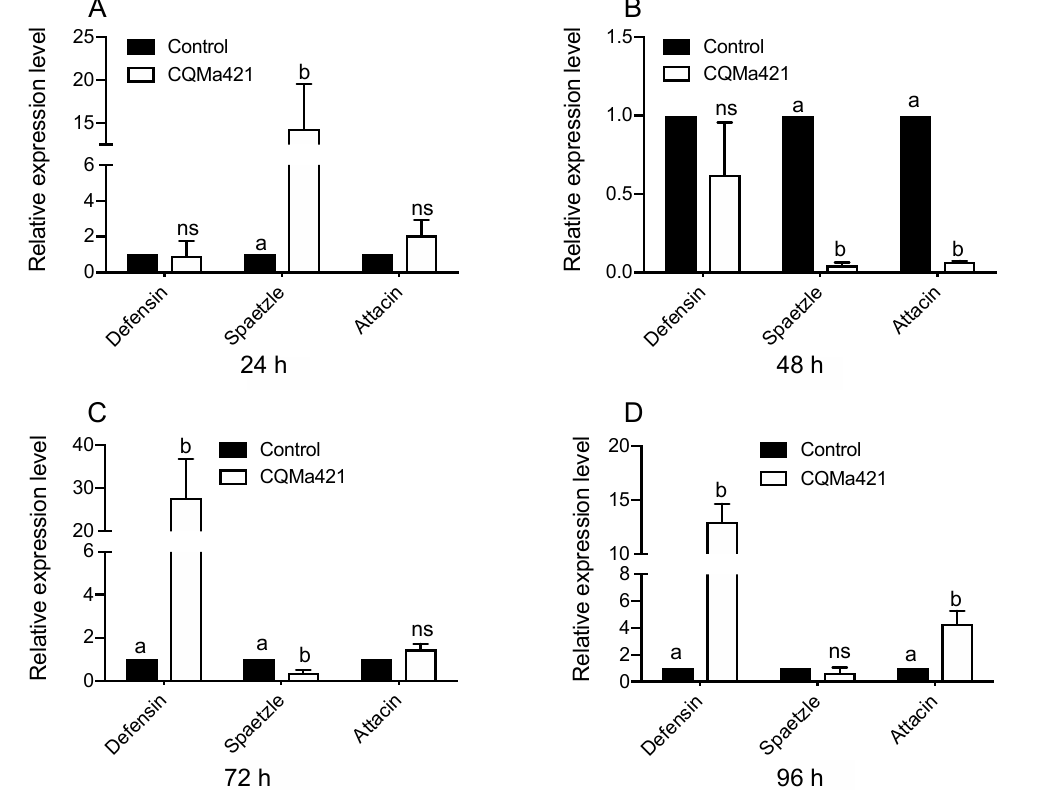
Figure 4. Relative expression of genes after challenge with M. anisopliae CQMa421. ( A ) The relative expression of defensin, spaetzle and attacin 24-h post infection; ( B ) the relative expression of defensin, spaetzle, and attacin 48 h post infection; ( C ) the relative expression of defensin, spaetzle and attacin 72 h post infection; ( D ) the relative expression of defensin, spaetzle and attacin 96 h post infection. The different letters indicate significant differences, and the bars represent the means ± SEs.